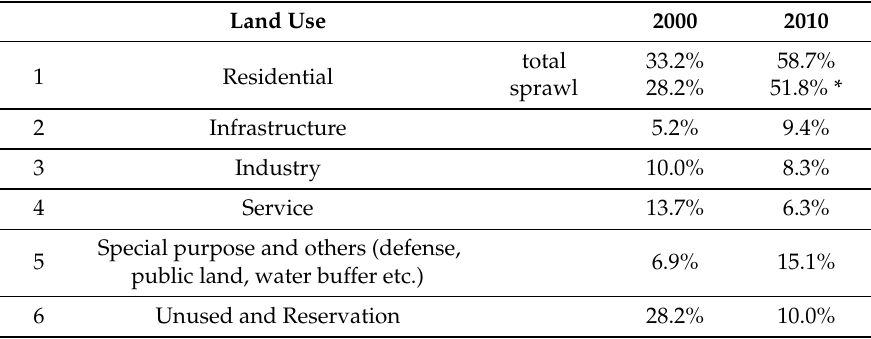
Table 2. Urban land-use change dynamic (data from Purevtseren et al. [32] and Myagmartseren et al.